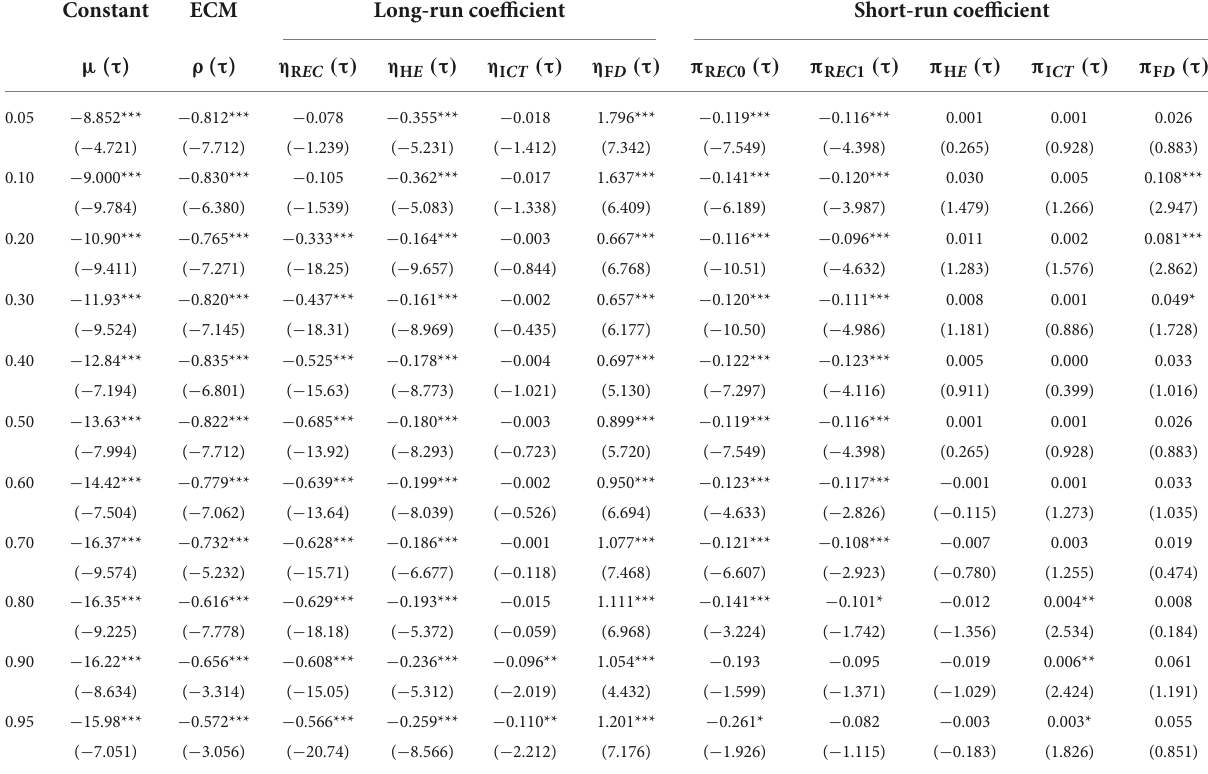
TABLE 4 QARDL estimates of CO 2